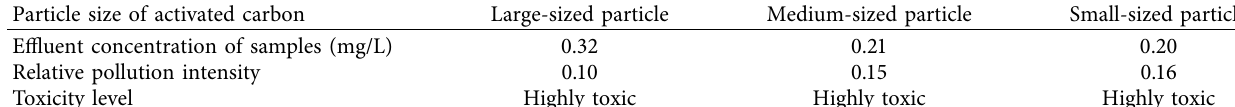
Table 4: Samples with different particle sizes of molecular toxicity of ecological environmental pollution.